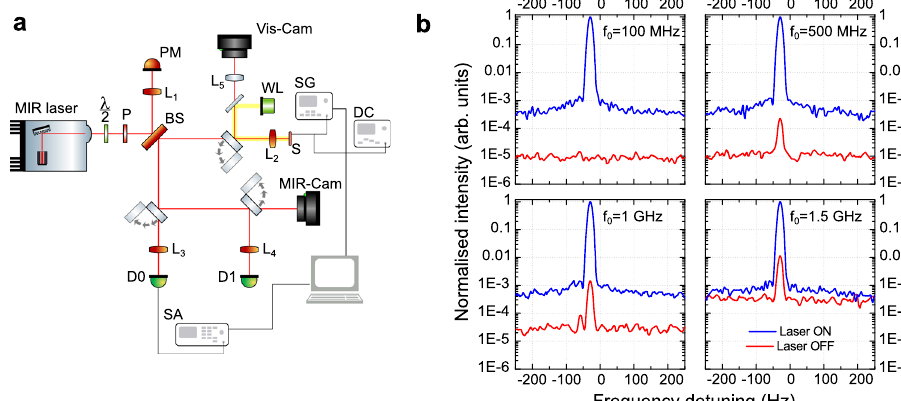
Fig. 3 Polariton-based amplitude modulation up to 1.5 GHz at 300 K. a Sketch of the experimental setup to measure the modulator bandwidth. The sample S is pumped with a commercial tunable mid-infrared QC laser focused with a ZnSe (L 2 ) lens; the back re fl ected beam is collected through the beam-splitter BS, and sent to the detectors D 0 (fast MCT Vigo detector with nominal bandwidth 1 KHz – 837 MHz) and D 1 (general purpose 50 MHz- bandwidth MCT detector, LN-cooled). A signal generator (RF or LF depending on the measurement) is used to apply the electrical bias to the sample. The electrical signal from the detector is then sent to speci fi c analyzers: a spectrum analyzer (SA) to collect the beat-note spectrum or a lock-in. PM power meter, WL white light, P polarizer, λ /2 half-wave plate, Vis-Cam visible camera, MIR-Cam MIR camera. b Normalized beat-note spectra obtained when the sample is fed with 10 dBm/DC@ − 989 mV with modulation frequencies 100 MHz, 500 MHz, 1 GHz, and 1.5 GHz from top left. The measurements are performed at room-temperature, and the measured sample is the small one (surface is 2 × 10 4 μ m 2 , p = 4.1 μ m). The QC laser frequency is 1010 cm − 1 . Two curves are shown for each panel: laser-on (solid blue line) and laser-off (solid red line). The modulator performs up to at least 1.5 coupled to a Fourier transform infrared spectrometer (FTIR) to retrieve the polaritonic positions at RT (and at 78 K) with no applied bias. The complete dispersion is shown in Supplementary Fig. 2: together with the measurements and simulations on an empty cavity (Supplementary Fig. 1), it permits to identify the fi rst 3 ribbon resonator modes. The TM 03 mode exhibits a clear Rabi splitting for patch sizes around p = 4 μ m.